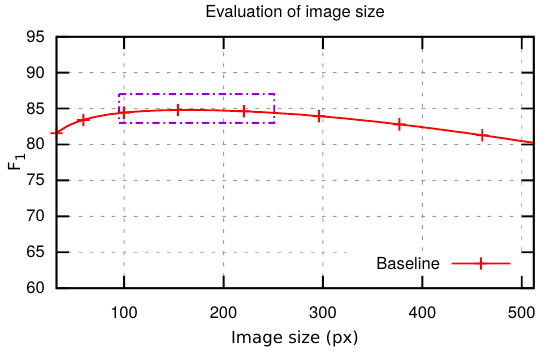
Figure 3. F 1 varying the image size parameter with the CNN model described in Table